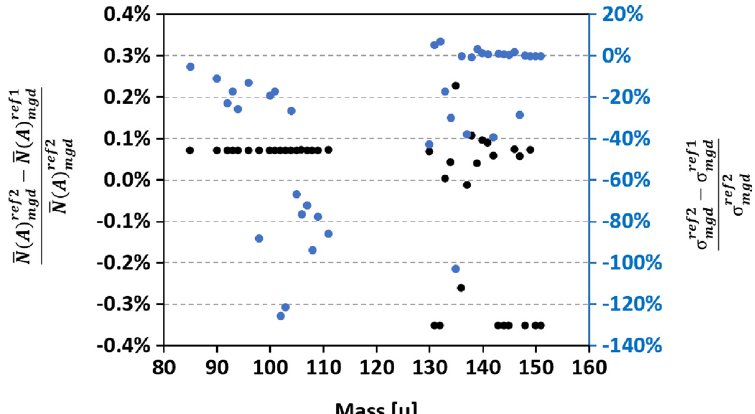
Fig. 8. The relative difference on N ð A Þ right axis, when the reference is Exp.1 or Exp.2. For the sake of the comparison, both sets of N ð A Þ normalized to 1.